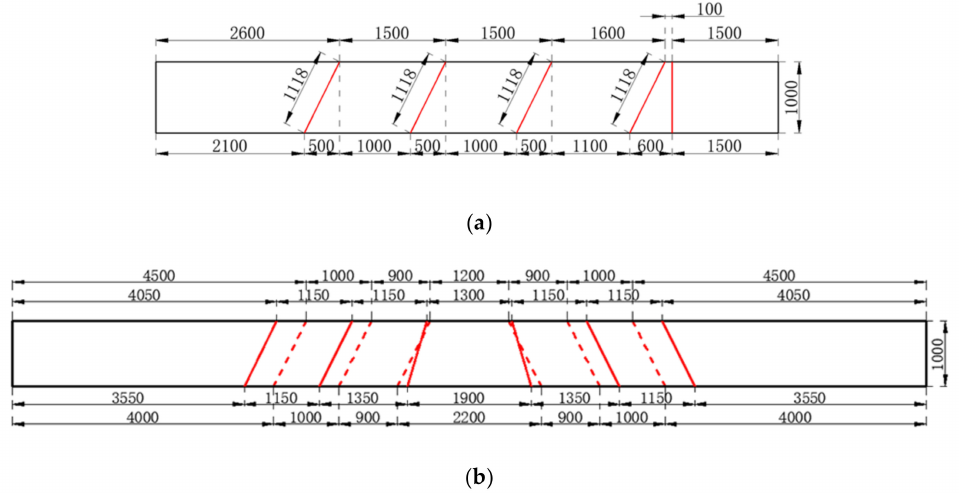
Figure 8. The sizes and locations of the crossed baffles installation at the upstream side of the AIG: ( a ) Y-positive view; ( b ) X-negative view.